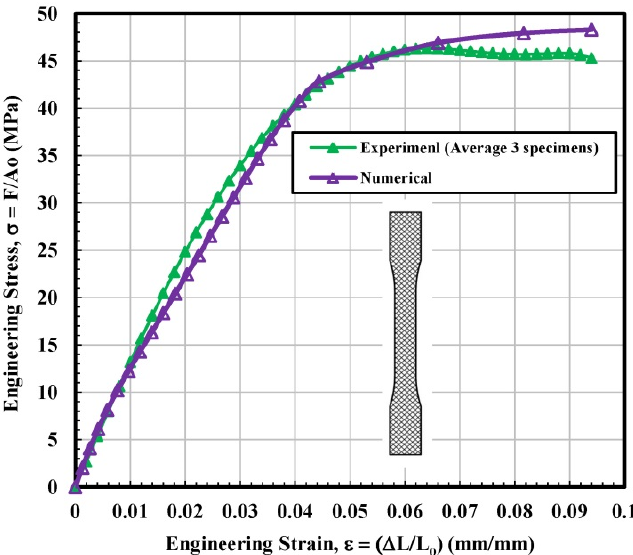
Figure 13. Engineering stress–strain curves for diamond tested specimens based on experimental and finite element analysis.